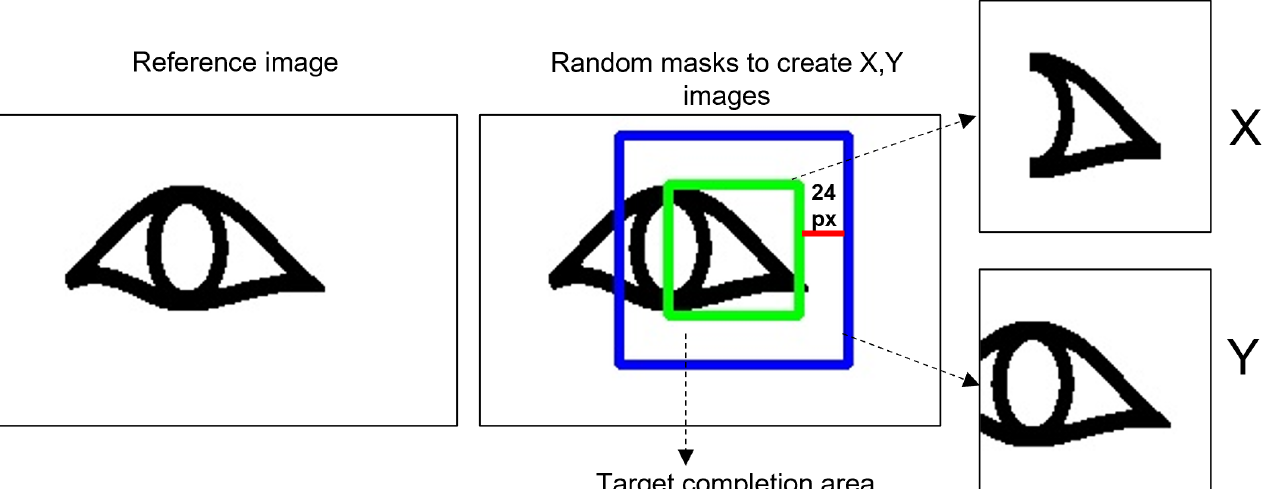
Figure 10. Example of how the training data for the decoration completion GAN model is